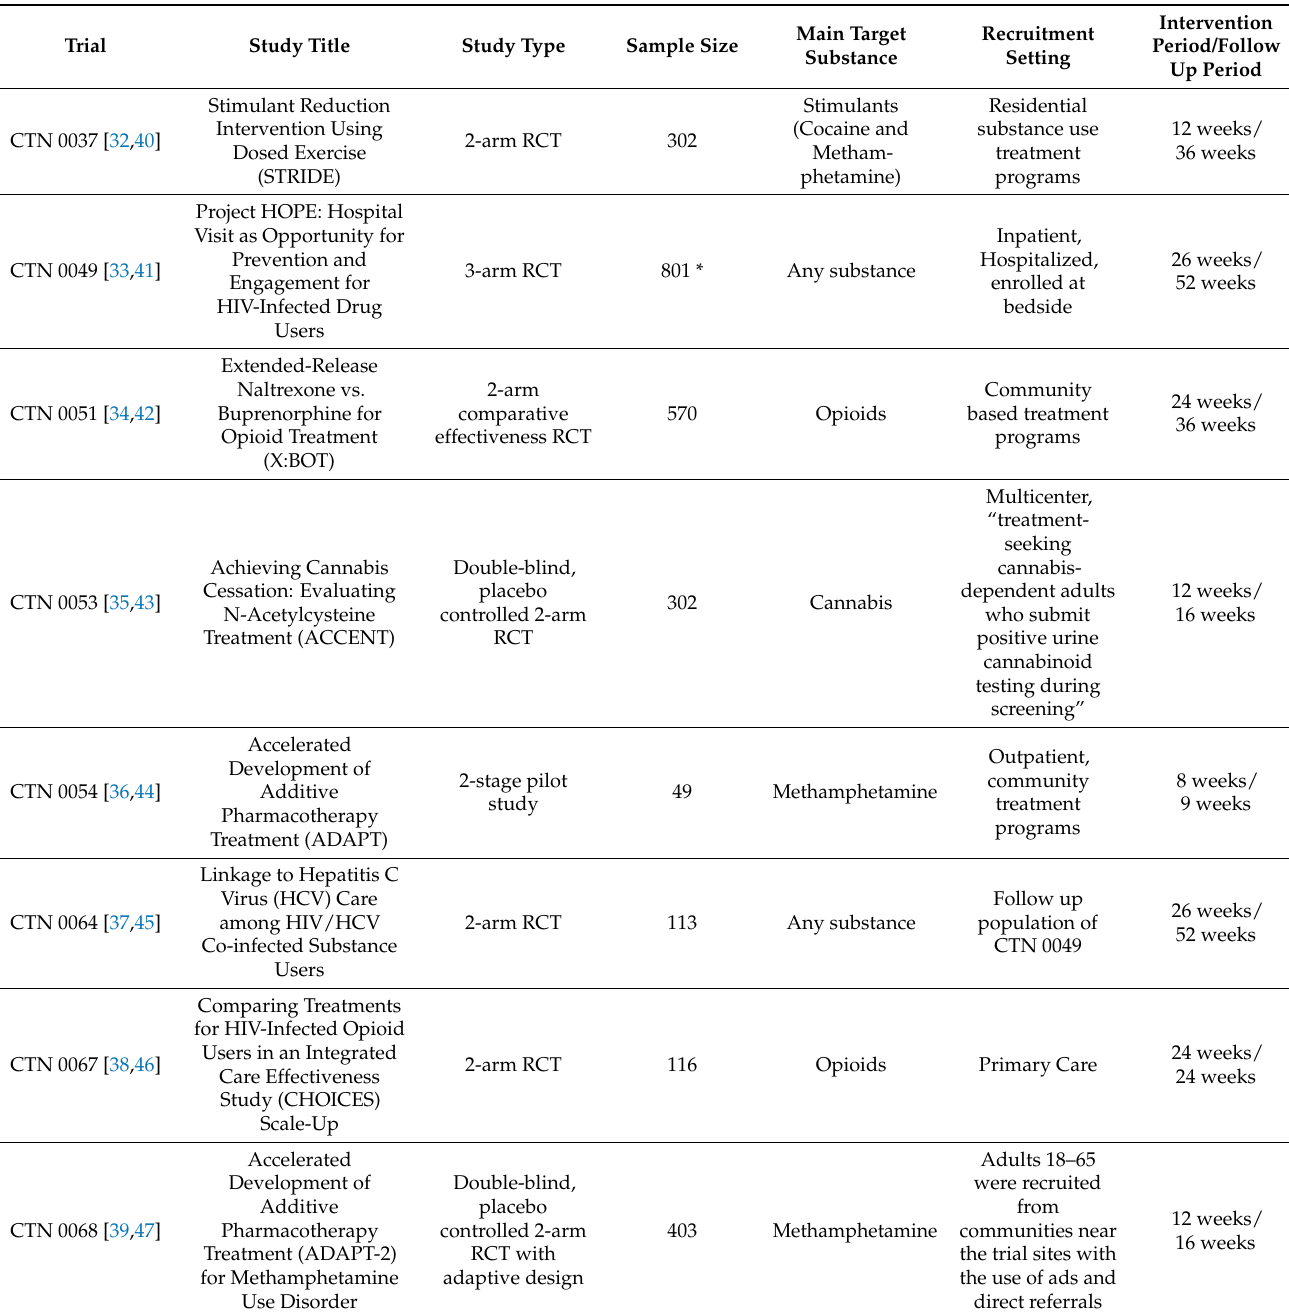
Table 1. Selected CTN Trial